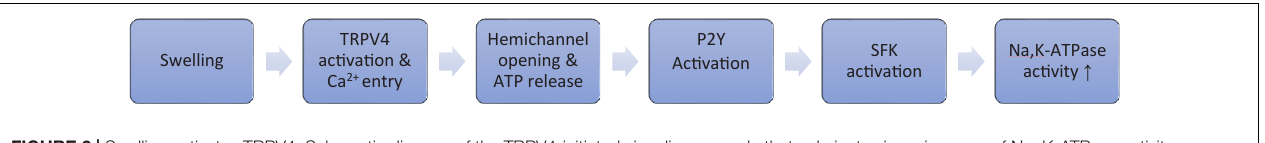
(right panel). Sodium and potassium homeostasis of the